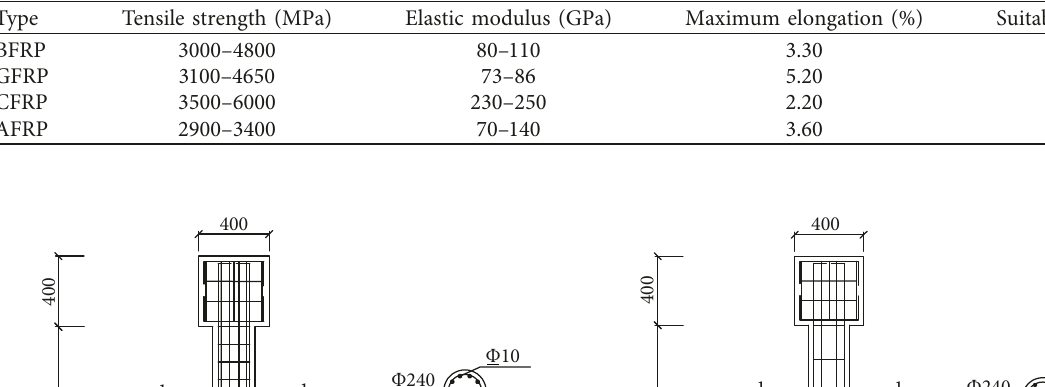
Table 1: Comparison of different FRPs.